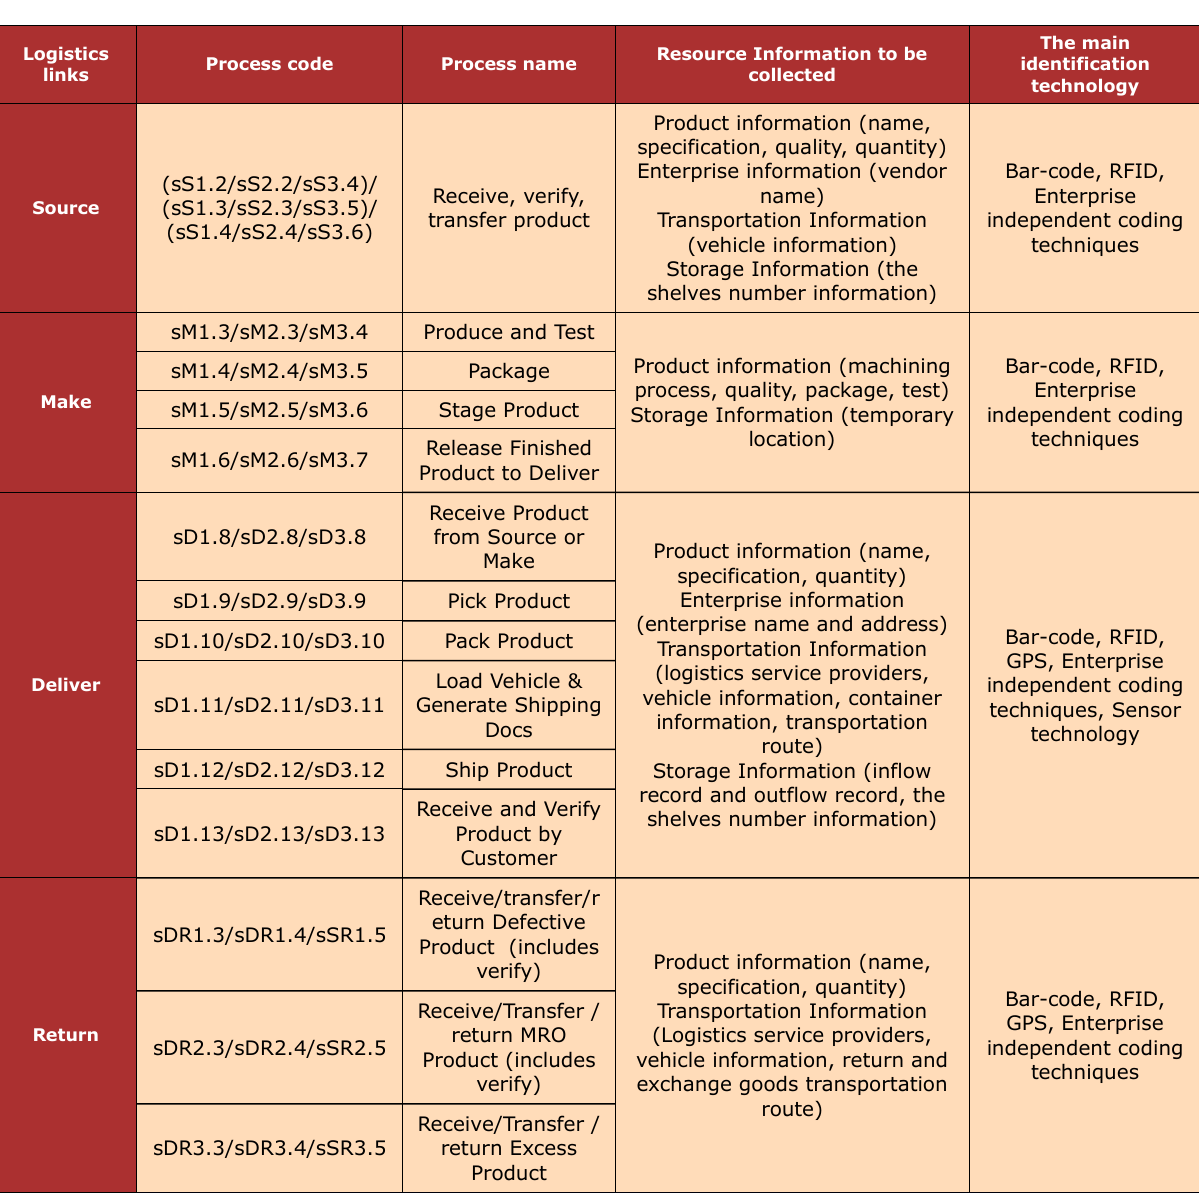
Table 1. Sub-processes of Using Identification Technology in SCOR10.0